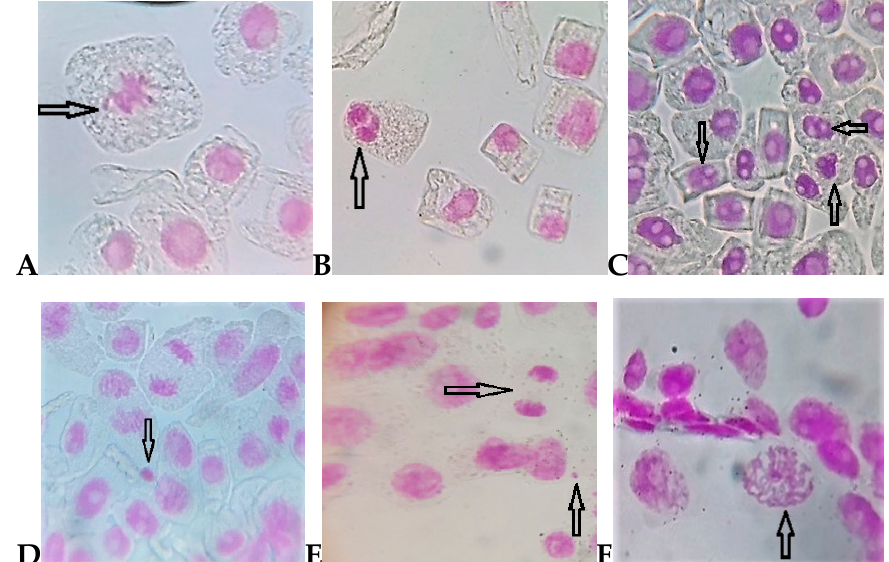
Figure 4. Some chromosomal aberrations and nuclear anomalies identified in meristematic cells of Allium cepa exposed to cycloxydim and quizalofop-p-ethyl herbicides: Fragments in metaphase ( A ); nuclear erosion ( B ); cells with lobulated nucleus ( C ); micronucleus ( D ); telophase stickiness and micronucleus ( E ); sticky chained metaphase in a polyploid cell ( F ).